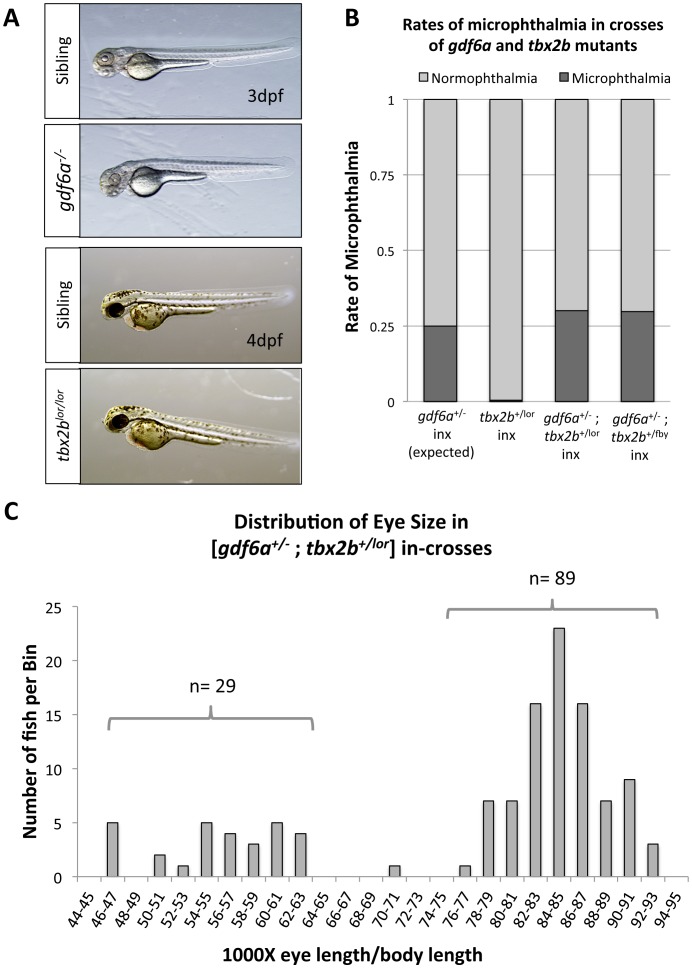
Disruption of tbx2b does not modify the gdf6a microphthalmic phenotype.
A. gdf6as327/s327 mutants exhibit microphthalmia (observed at 3dpf) but tbx2b−/− mutants (lor and fby) do not, indicating that disruption of tbx2b does not interfere with identical pathways as gdf6a in early eye development. B. Microphthalmia is rarely observed in tbx2b mutant in-crosses (inx) alone (tbx2b+/lor in-cross shown, n = 220) compared to in-crosses of gdf6a+/s327, which yield 25% with microphthalmia (following Mendelian ratios of inheritance and recessive phenotype). When [gdf6a+/s327;tbx2b+/lor] or [gdf6a+/s327;tbx2b+/fby] compound heterozygous mutants are in-crossed (n = 121 and 195 respectively, both at 6dpf), rates of microphthalmia do not increase significantly from rates expected of in-crosses of gdf6a+/s327 alone (X
2 p = 0.873 and p = 0.137, respectively). C. The eye size compared to body length (shown as ratio) of a [gdf6a+/s327;tbx2b+/lor] in-cross does not reveal a subset of intermediate eye sizes, but remains bimodal, with the normophthalmic curve (right curve) showing a normal distribution (Shapiro-Wilk Normality test, W = 0.9888, p = 0.6532) (n = 118, 4dpf).